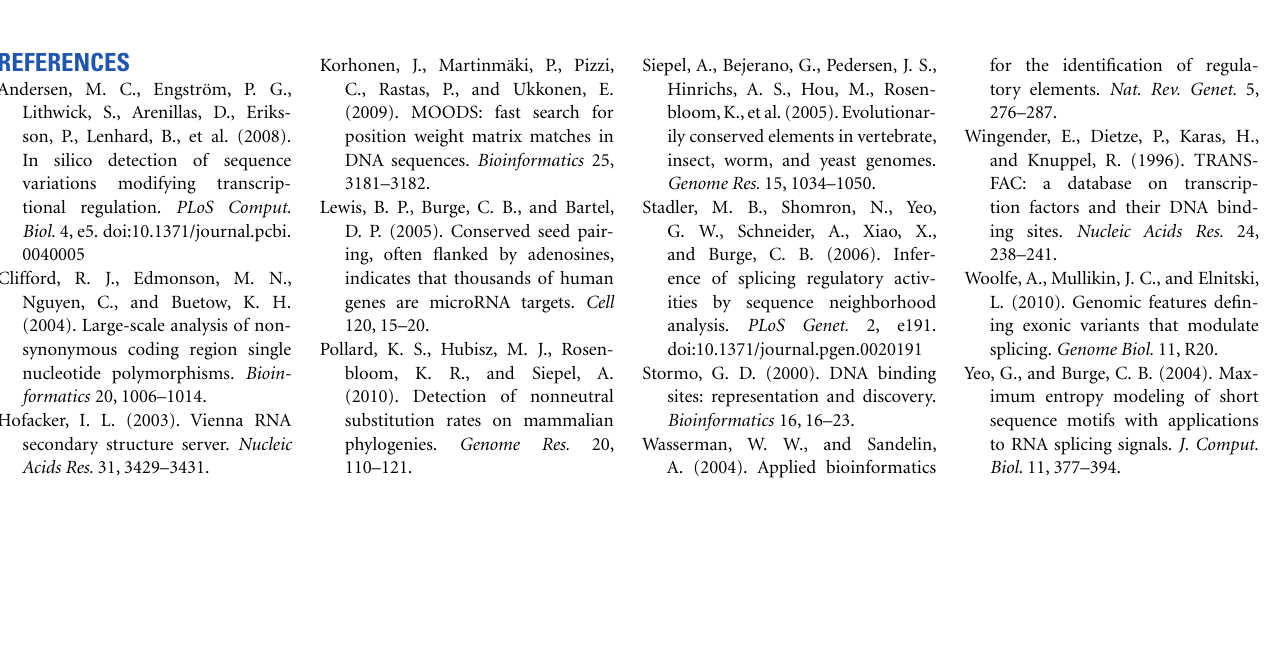
FIGUREA3 | Relationship between the number of ns cSNVs with polyphen 2.0 scores > 0.8 that would be declared as novel anAfrican individual’s ns cSNVs were compared to a reference panel made up of European,AfricanYoruban orAfrican non-Yoruban individuals as a